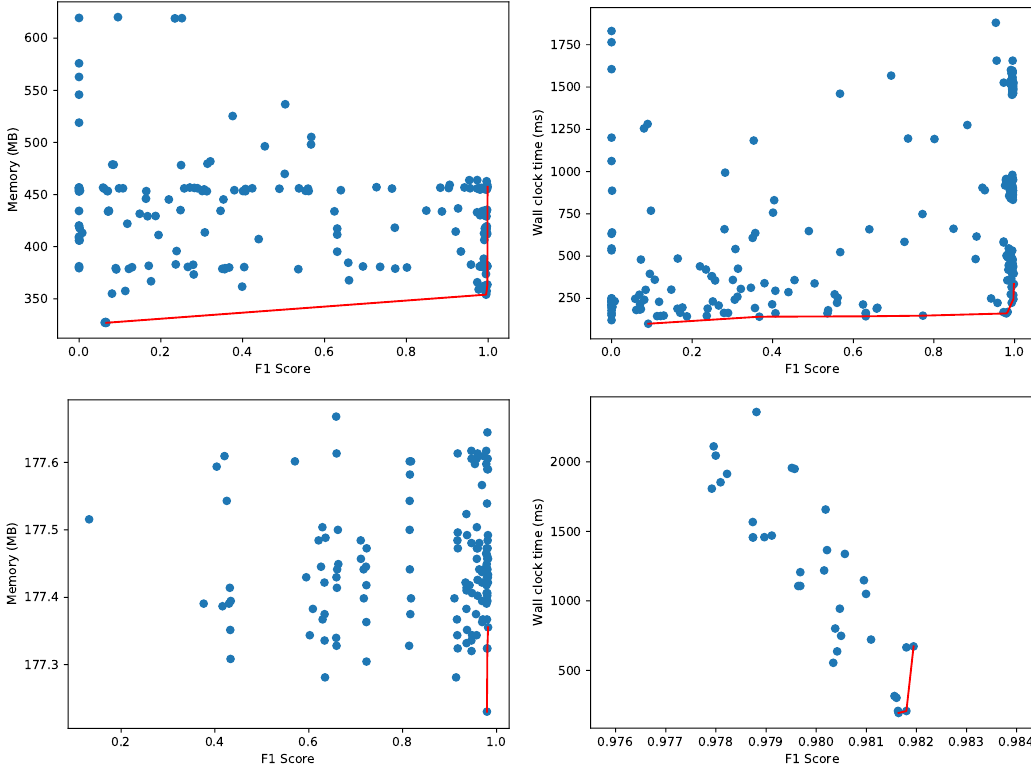
Figure 13. Pareto fronts for memory ( left ) and wall clock time ( right ) for the Enterprise anomaly dataset using AutoSklearn ( top ) and One-Class SVM ( bottom